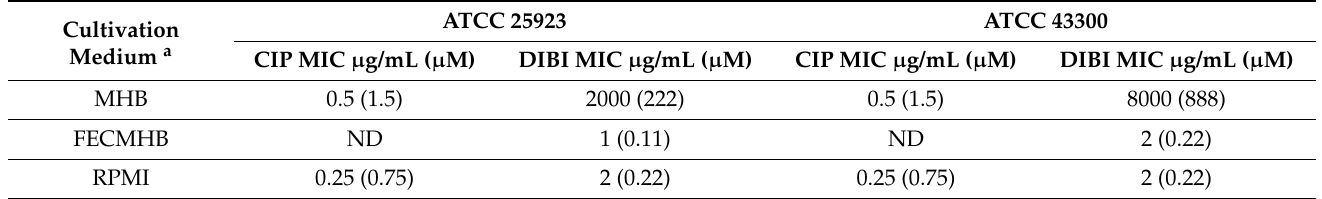
Table 2. Effect of growth medium on Staphylococcus aureus sensitivity to ciprofloxacin and